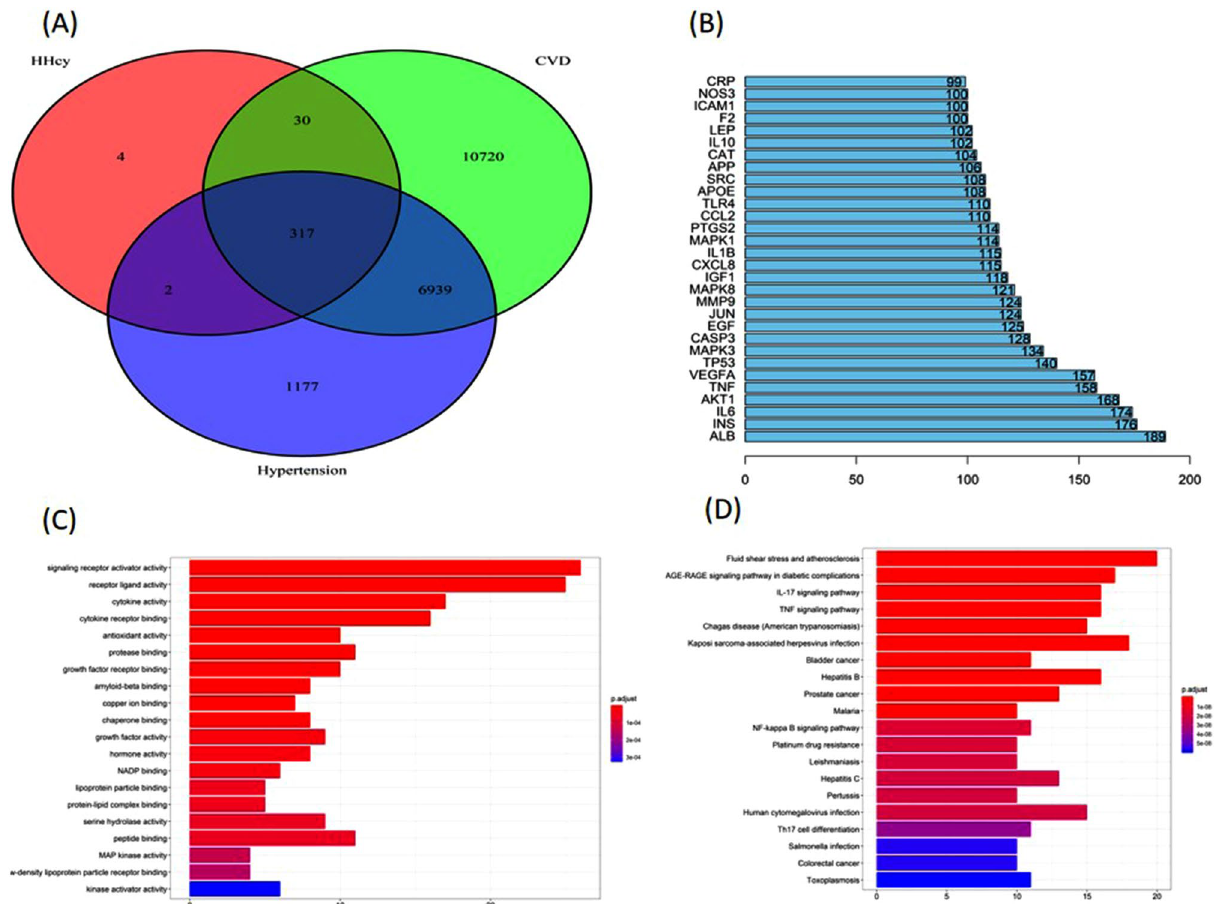
Figure 4. Bionetwork analysis diagram. ( A ) VENN diagram of candidate targets. ( B ) Top 30 core material molecules in the intersection genes. ( C ) Top 20 biological processes from the intersection genes. ( D ) Top 20 signal pathways from the intersection